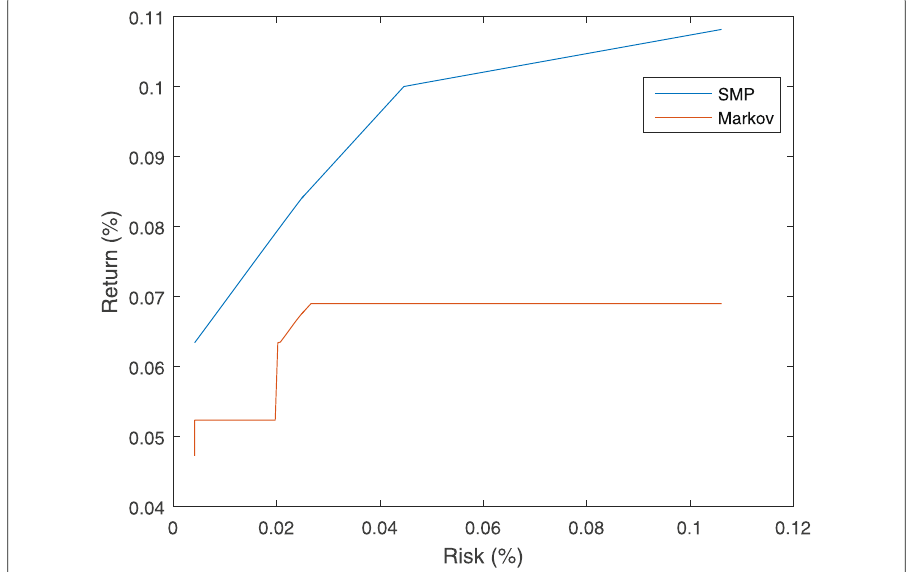
Fig. 1 Efficient frontier of min-max absolute deviation optimization model for SMP and Markov